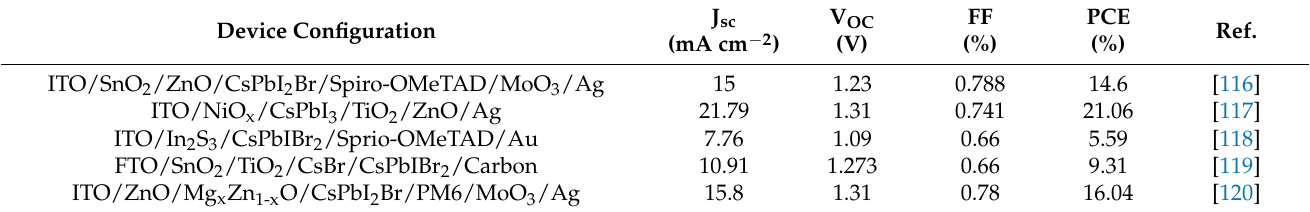
Table 3. Summary of various inorganic PSCs’ performance using interface